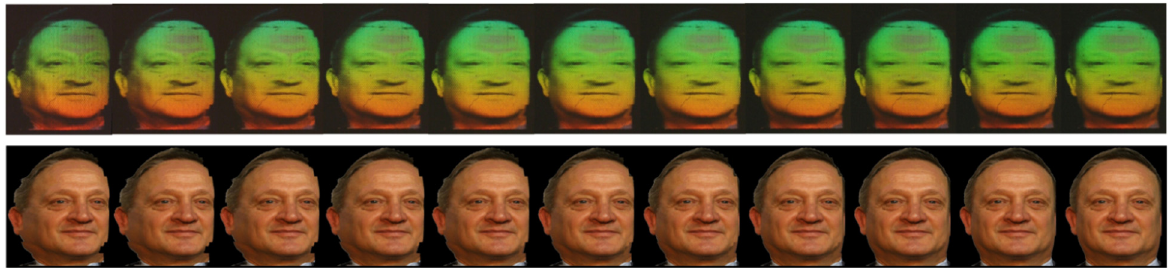
Figure 10. The reconstructed images ( upper row ) of the projections of the 3D object ( lower row ), recorded in the rainbow hologram using the KineMax device.